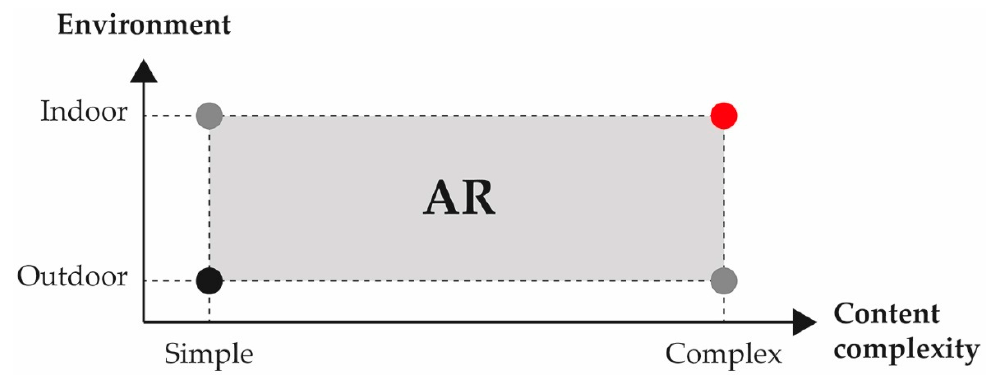
Figure 5. Graphical diagram with some domain variables.